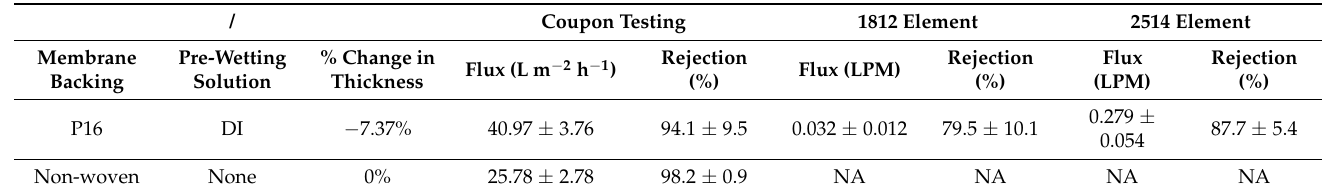
Table 4. Industrial demonstration of the fabrication method and performance of the commercial-sized membrane elements. (3.4 bar, 500 ppm NaCl) (15 bar, 2000 ppm). Negative sign indicates reduction in thickness compared to the non-woven substrate-based